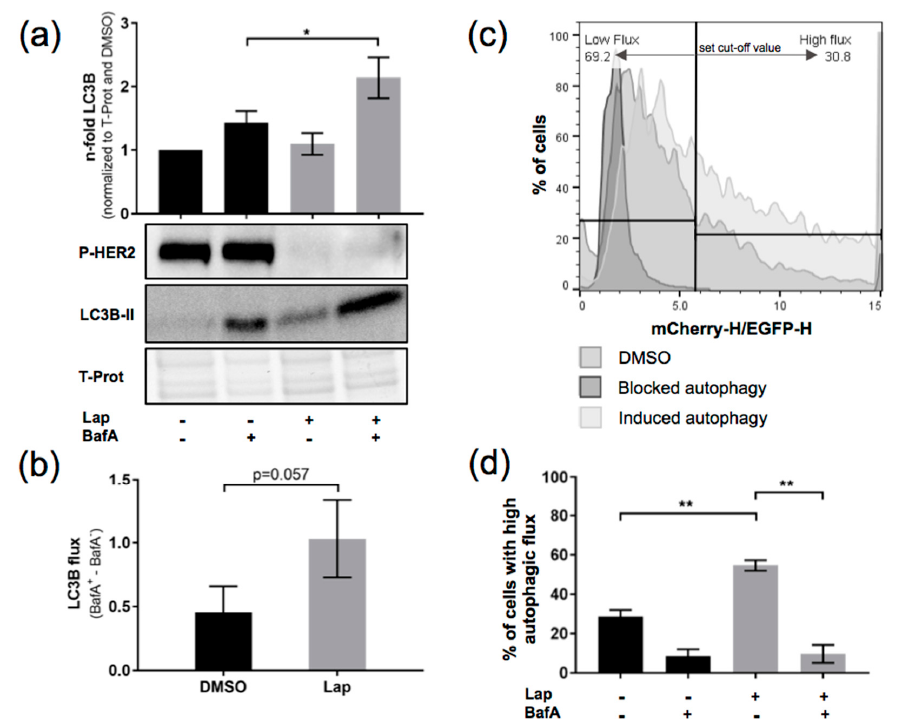
Figure 1. Induction of autophagic flux in OE19 upon Lapatinib treatment. ( a ) LC3B flux was assessed comparing control and BafilomycinA (BafA)-treated (200 nM, 2 h) OE19 upon Lapatinib treatment (120 nM, 24 h). LC3 band intensities were quantified using ImageJ software. Total protein was used as a loading control, and Phospho-Her2 for Lapatinib treatment ( n = 3). ( b ) LC3B flux was calculated from data in ( a ) as follows: BafA + -BafA − values for each condition. ( c ) FACS analysis of mCherry-EGFP-LC3B-expressing OE19 cells upon induction or blockade of autophagy with indication of the chosen cut-off value for high respectively low autophagic flux. ( d ) Quantification of the FACS analysis showing % of cells with high autophagic flux ( n = 3). Cells were treated as in ( a ). The error bars represent SD, statistical significance was determined by Mann–Whitney U test: * p ≤ 0.05, ** p ≤ 0.01.